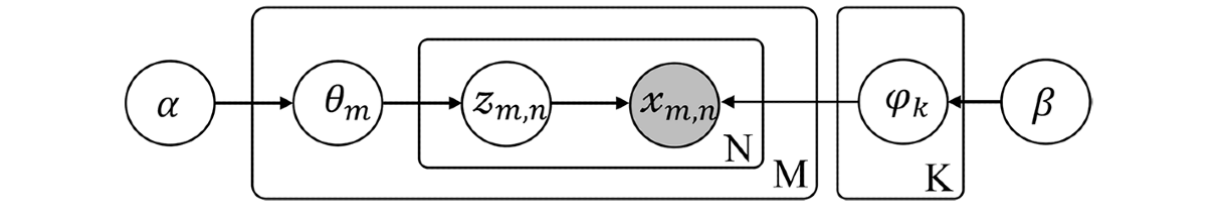
Figure 1. Graphical representation of the latent Dirichlet allocation model. K: number of topics; M: number of documents; N: number of words in each document; x: observed words in the document m; z: topic of nth word in a document m; θ : topic distribution for document m (document-topic distribution); φ : topic-word distribution; α : hyperparameter of θ ; β : hyperparameter of φ .